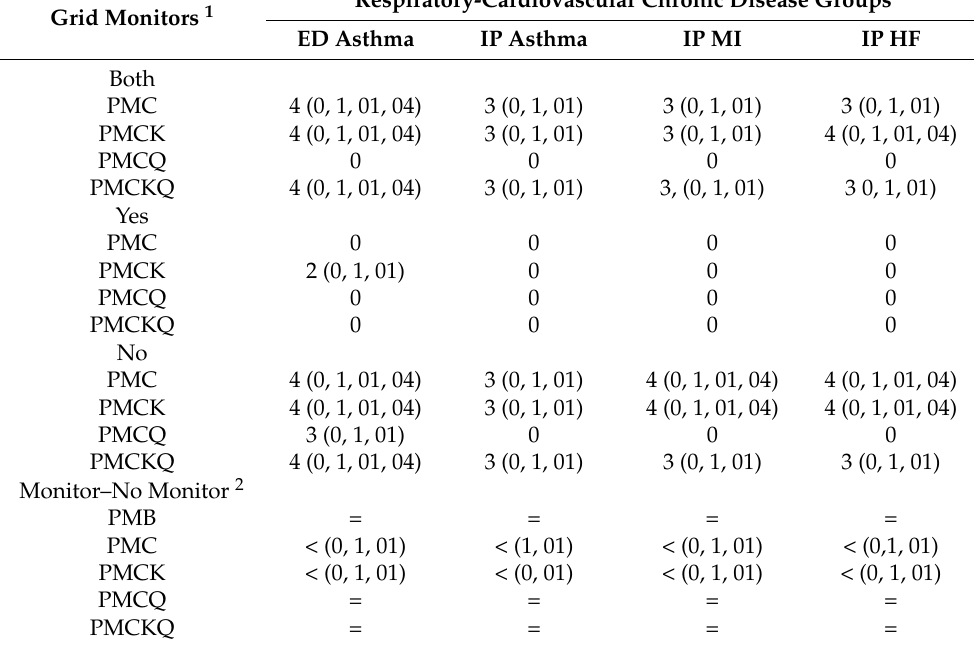
Table 8. Lag grid analyses identified the size of homogeneous spatial areas (HOSAs), in multiples of one 12-km-wide Community Multiscale Air Quality (CMAQ) grid, when the AOD-PM 2.5 fused surface ORs are greater than the baseline PMB ORs (Top), and the AOD–PM 2.5 and baseline PMB fused surface ORs in grids without air monitors are compared to ORs in grids with air monitors (Bottom). Respiratory-Cardiovascular Chronic Disease Groups Grid Monitors 1 ED Asthma IP Asthma IP MI IP